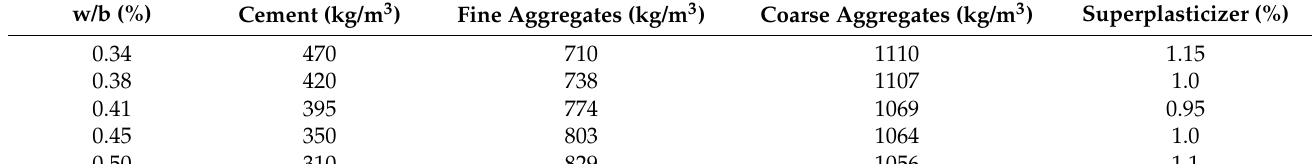
Table 7. Mix proportions of concrete with different w/b ratios.